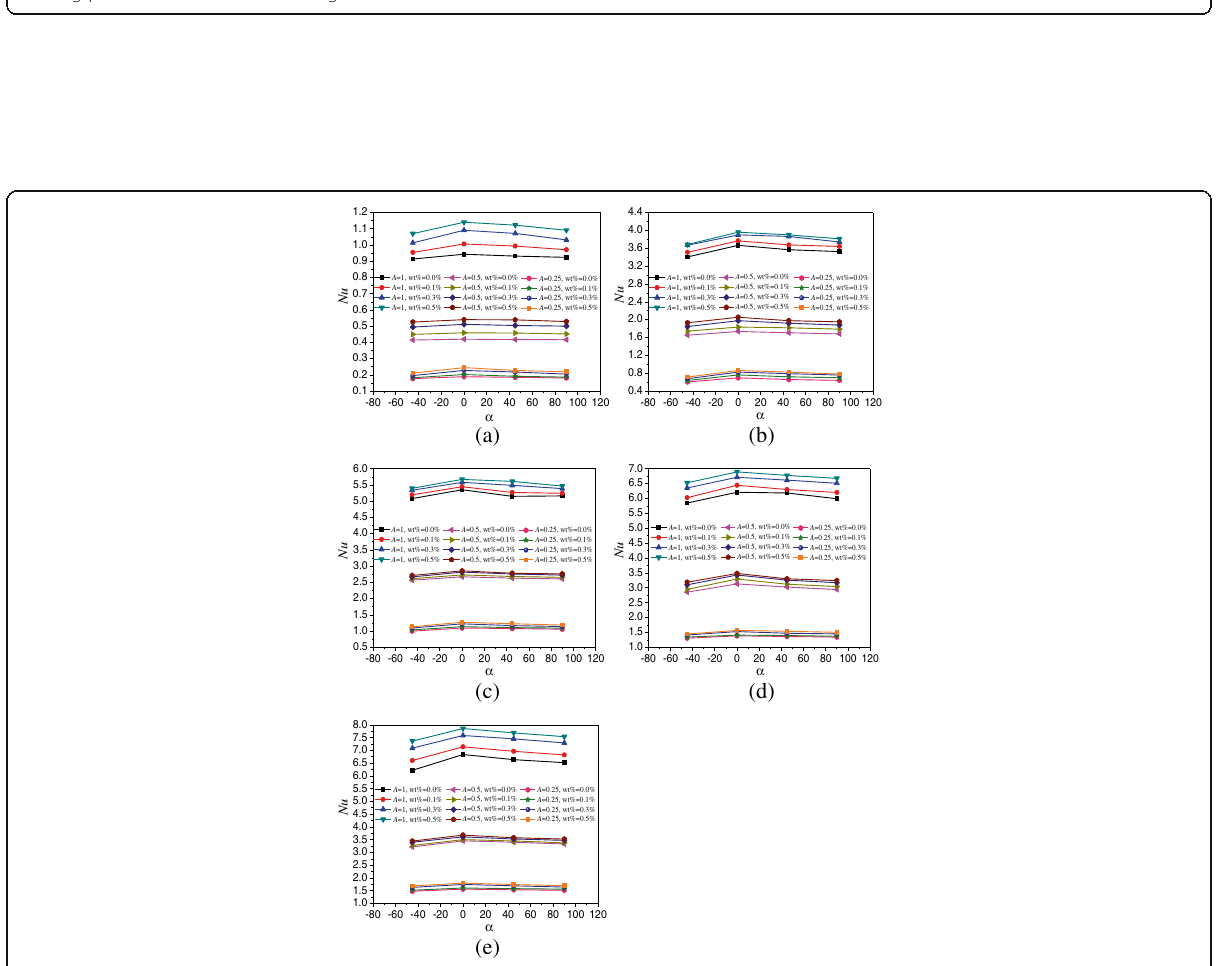
Fig. 14 Nusselt numbers comparison between different aspect ratios. Comparison of average Nusselt numbers of nanofluid in different aspect ratios ( A =1:1, A =1:2, and A =1:4) and rotation angle enclosures at different heating powers. a Q =1 W. b Q =5 W. c Q =10 W. d Q =15 W. e Q =20 W